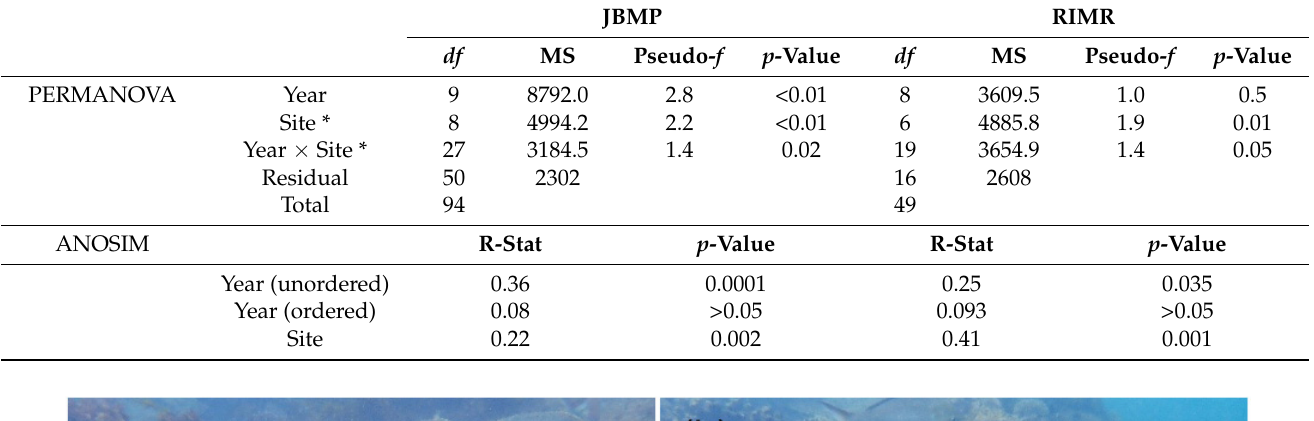
Table 3. Statistical results for PERMANOVA and ANOSIM routines based on Bray–Curtis similarity matrices derived from per-cent-cover genera-assemblage data collected in two marine parks, at sites where hard corals were observed in at least three different years. Data were derived from quadrats collected along transects, which were used as replicates. Hard-coral observations not identified to genera were excluded. * denotes random effects.